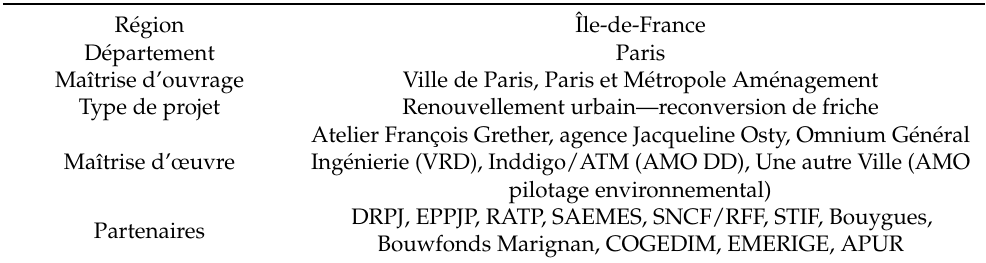
Table 13. Clichy-Batignolles. Source: Authors’ elaboration (2022) based on data from the site http://www.ecoquartiers.logement.gouv.fr (accessed on 19 June 2022).